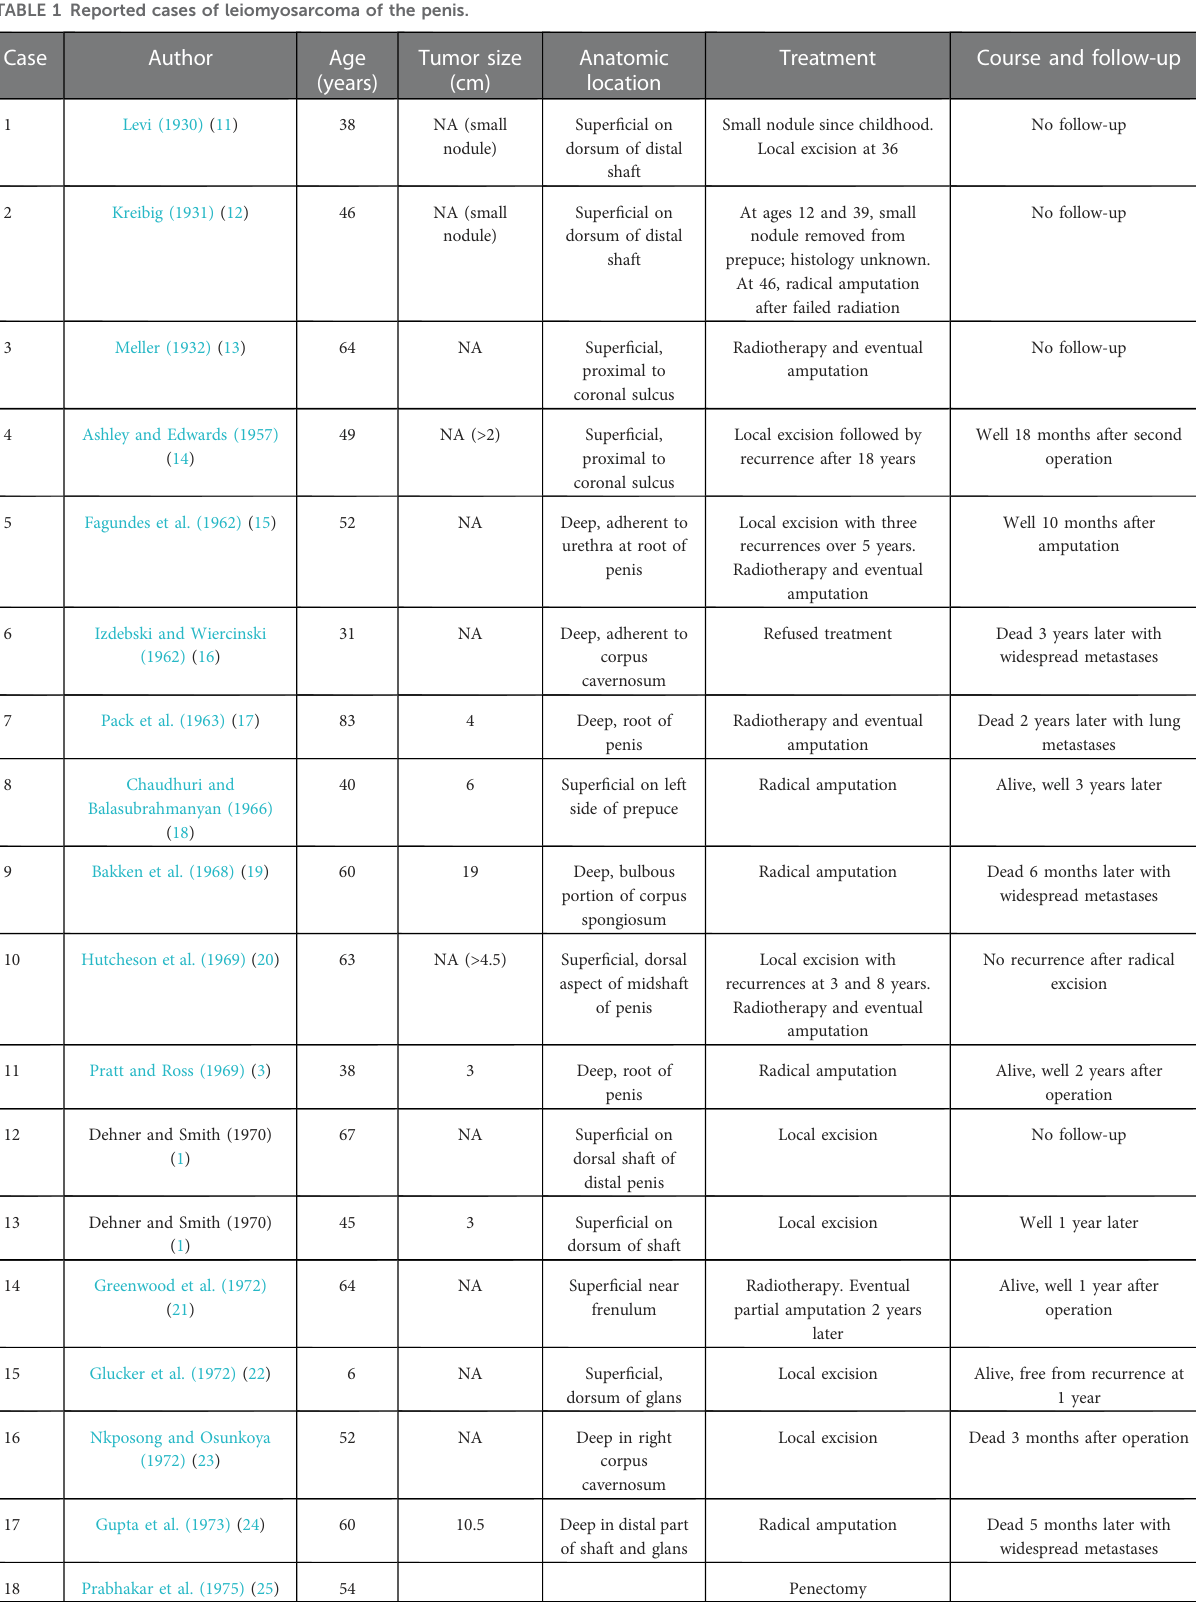
TABLE 1 Reported cases of leiomyosarcoma of the